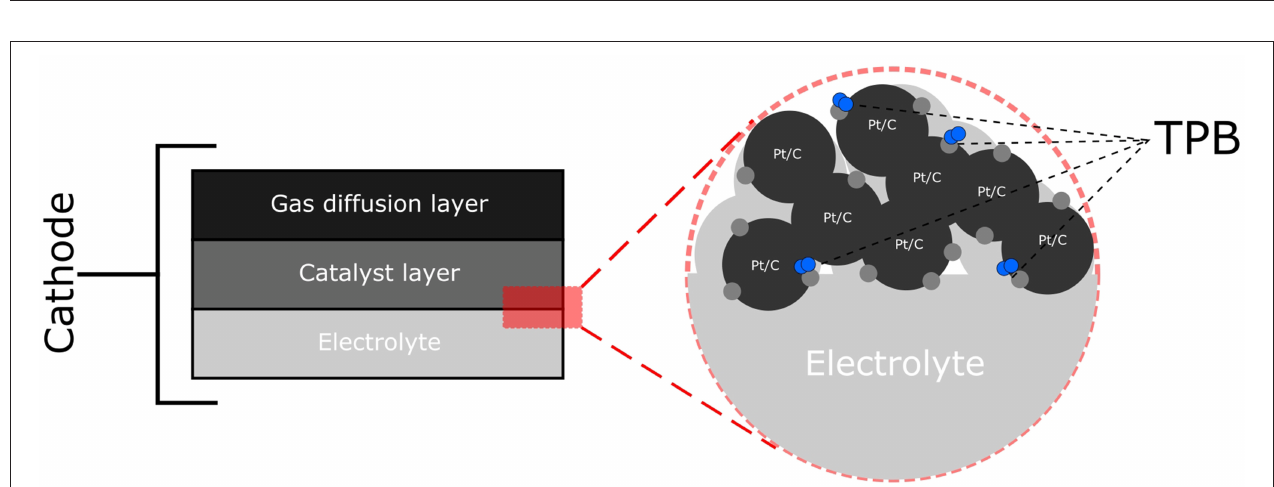
FIGURE 1 | A general schematic of a PEMFC. H 2 (fuel) flows in to the anodic side where H 2 dissociates into protons and electrons. The electrons flow through the circuit while the protons are transferred via the electrolyte (Nafion®) to the cathodic side. Here they meet O 2 at the cathode and combine to form H 2 O.